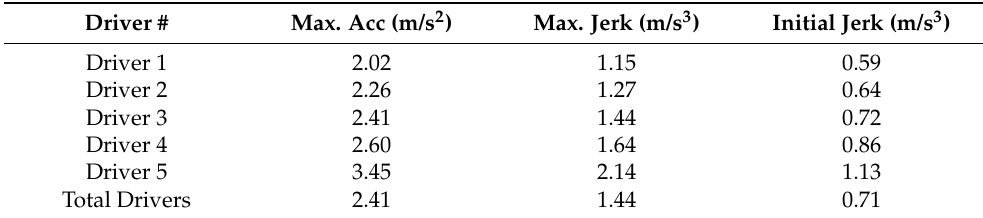
Figure 7. KDE of the maximum acceleration for each driver and the total number of drivers.